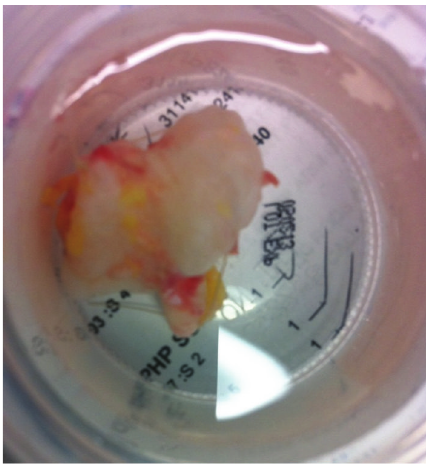
Figure 3: Gross pathological specimen of resected tumor showing dumbbell